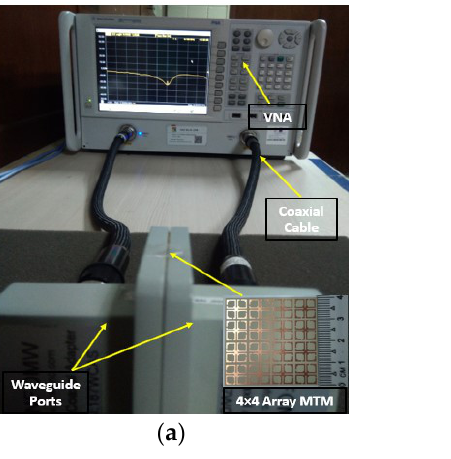
Figure 12. ( a ) Photographs of the array experimental setup with the fabricated prototype (wave- guide ports: A − INFOMW, P/N:187WCAS and A − INFOMW, P/N:137WCAS). ( b ) Comparison of uide ports: A-INFOMW, P/N:187WCAS and A-INFOMW, P/N:137WCAS). ( b ) Comparison of the the simulated and experimental results of the developed DNG MM structure. simulated and experimental results of the developed DNG MM